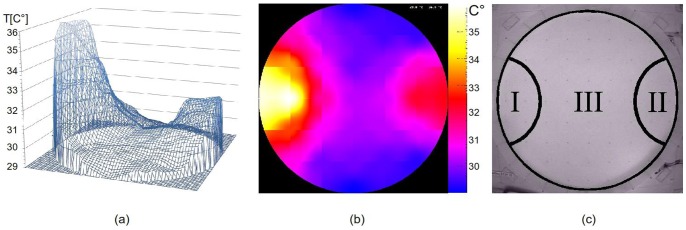
Complex thermal gradient and evaluation zones.(A) 3-dimensional and (B) colour-coded representation of the thermal gradient used for the discrimination experiments. The targeted temperatures were as follows: optimum (left zone) 36°C, centre of the arena (outside the zones) 31°C and sub-optimum (right zone) 32°C. (C) Picture from the arena with marked zones used for evaluation: I) optimum: left zone (11,2% of the total area), II) sub-optimum: right zone (11,2% of the total area), III) outside the zones (77,6% of the total area).